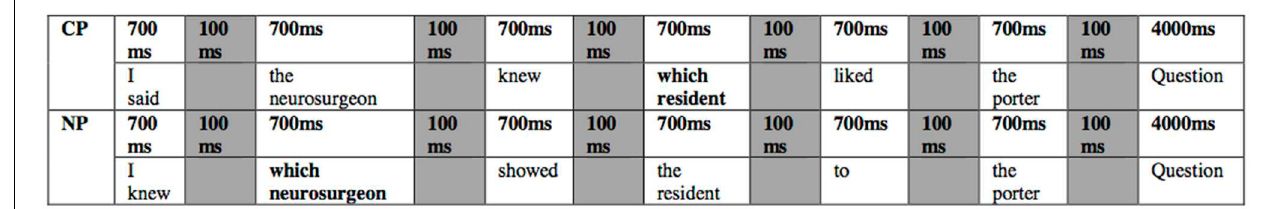
FIGURE 1 | Trial Dynamics of sentence presentation phrase/word by phrase/word.